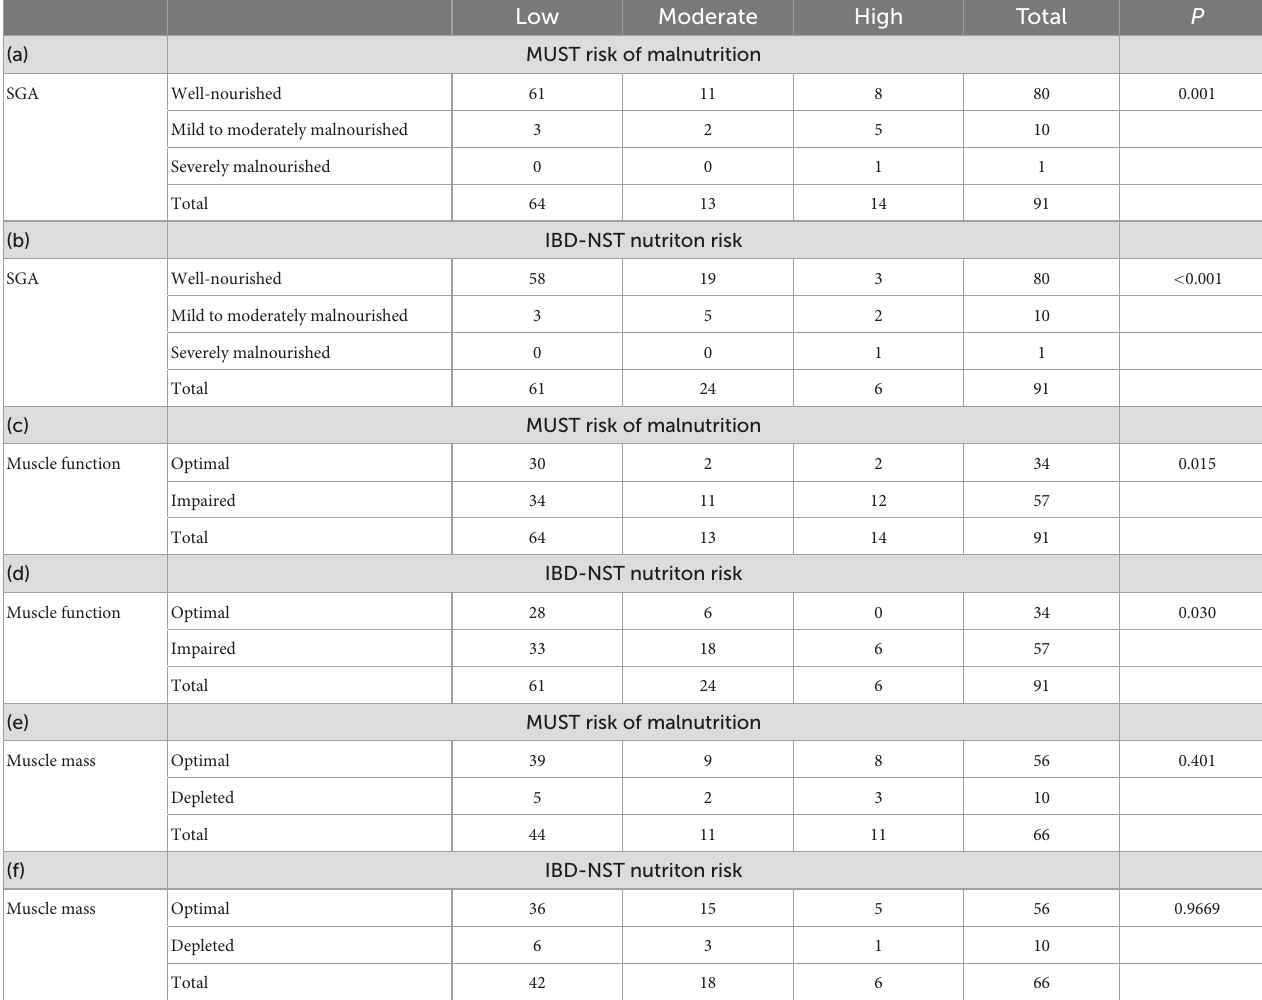
TABLE 2 Convergent validity of the Final IBD-NST and MUST compared with markers of nutritional status (Cohort 2a, n = 91). Low